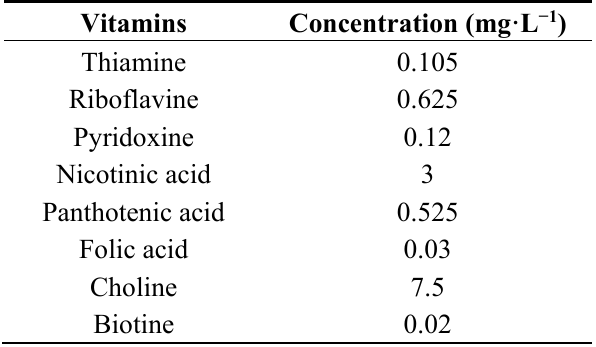
Table 1. Vitamin supplementation in defined